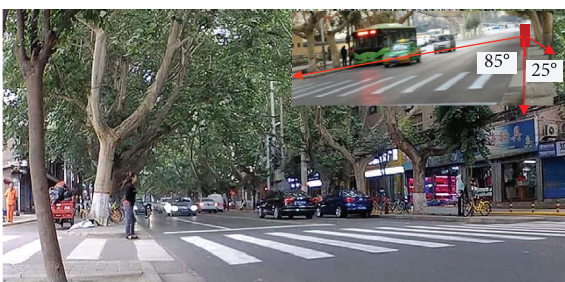
Figure 5: Photograph of the study site: lidar detection angle is 110 ° . It can completely cover the whole road.